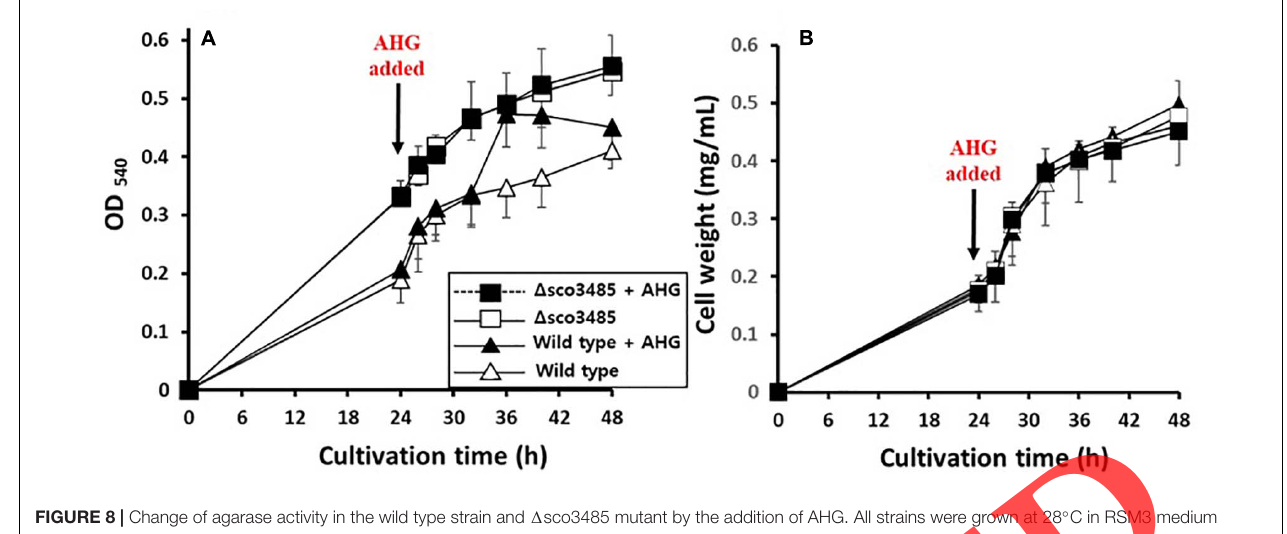
FIGURE 8 | Change of agarase activity in the wild type strain and (cid:49) sco3485 mutant by the addition of AHG. All strains were grown at 28 ◦ C in RSM3 medium (10 mL) for 24 h, and AHG (10 mM) was added to each culture broth. All data shown are mean values from at least three replicate experiments. Error bars indicate standard deviations of the means ( n = 3). Agarase activity (A) and cell growth (B) of the (cid:49) sco3485 mutant ( (cid:3) ) and wild type S. coelicolor A3(2) ( (cid:77) ) and the (cid:49) sco3485 mutant ( (cid:110) ) and wild type S. coelicolor A3(2) ( (cid:78) ) after feeding